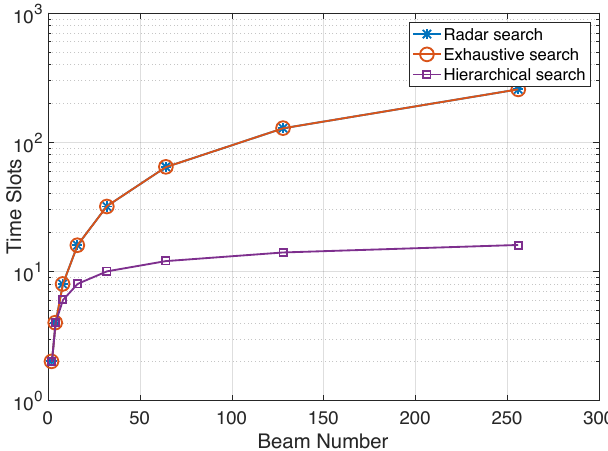
Figure 9. Beam search time in MIMO radar system by the first base station.